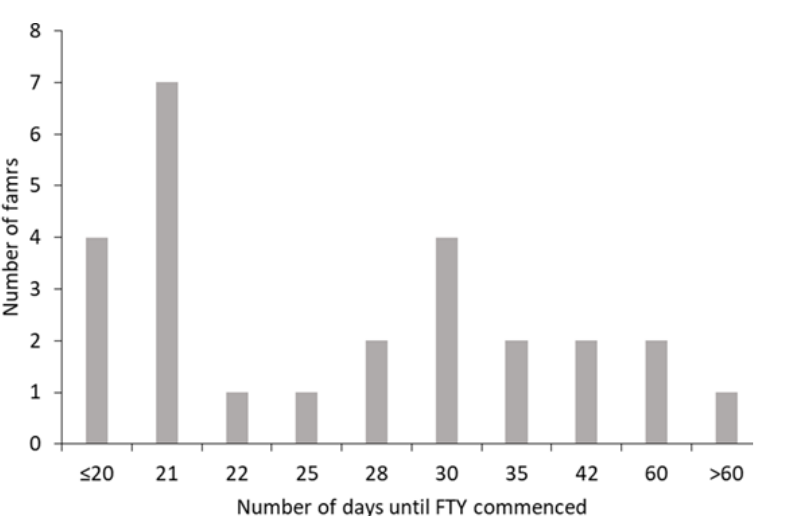
Figure 1. Duration of concentrate build-up periods before cows were offered concentrates on an FTY basis.